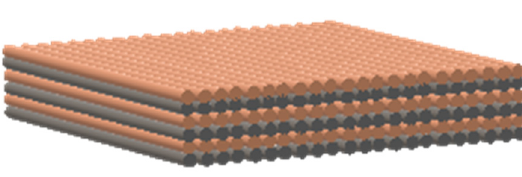
Figure 1. Unidirectional structure.